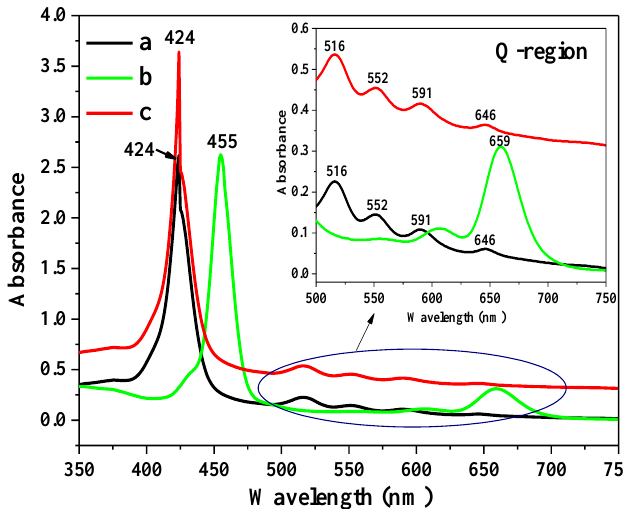
Figure 6. UV-vis absorption spectra of TNPP solutions (a) before and after exposure to (b) H 2 S and (c) EDA vapors.